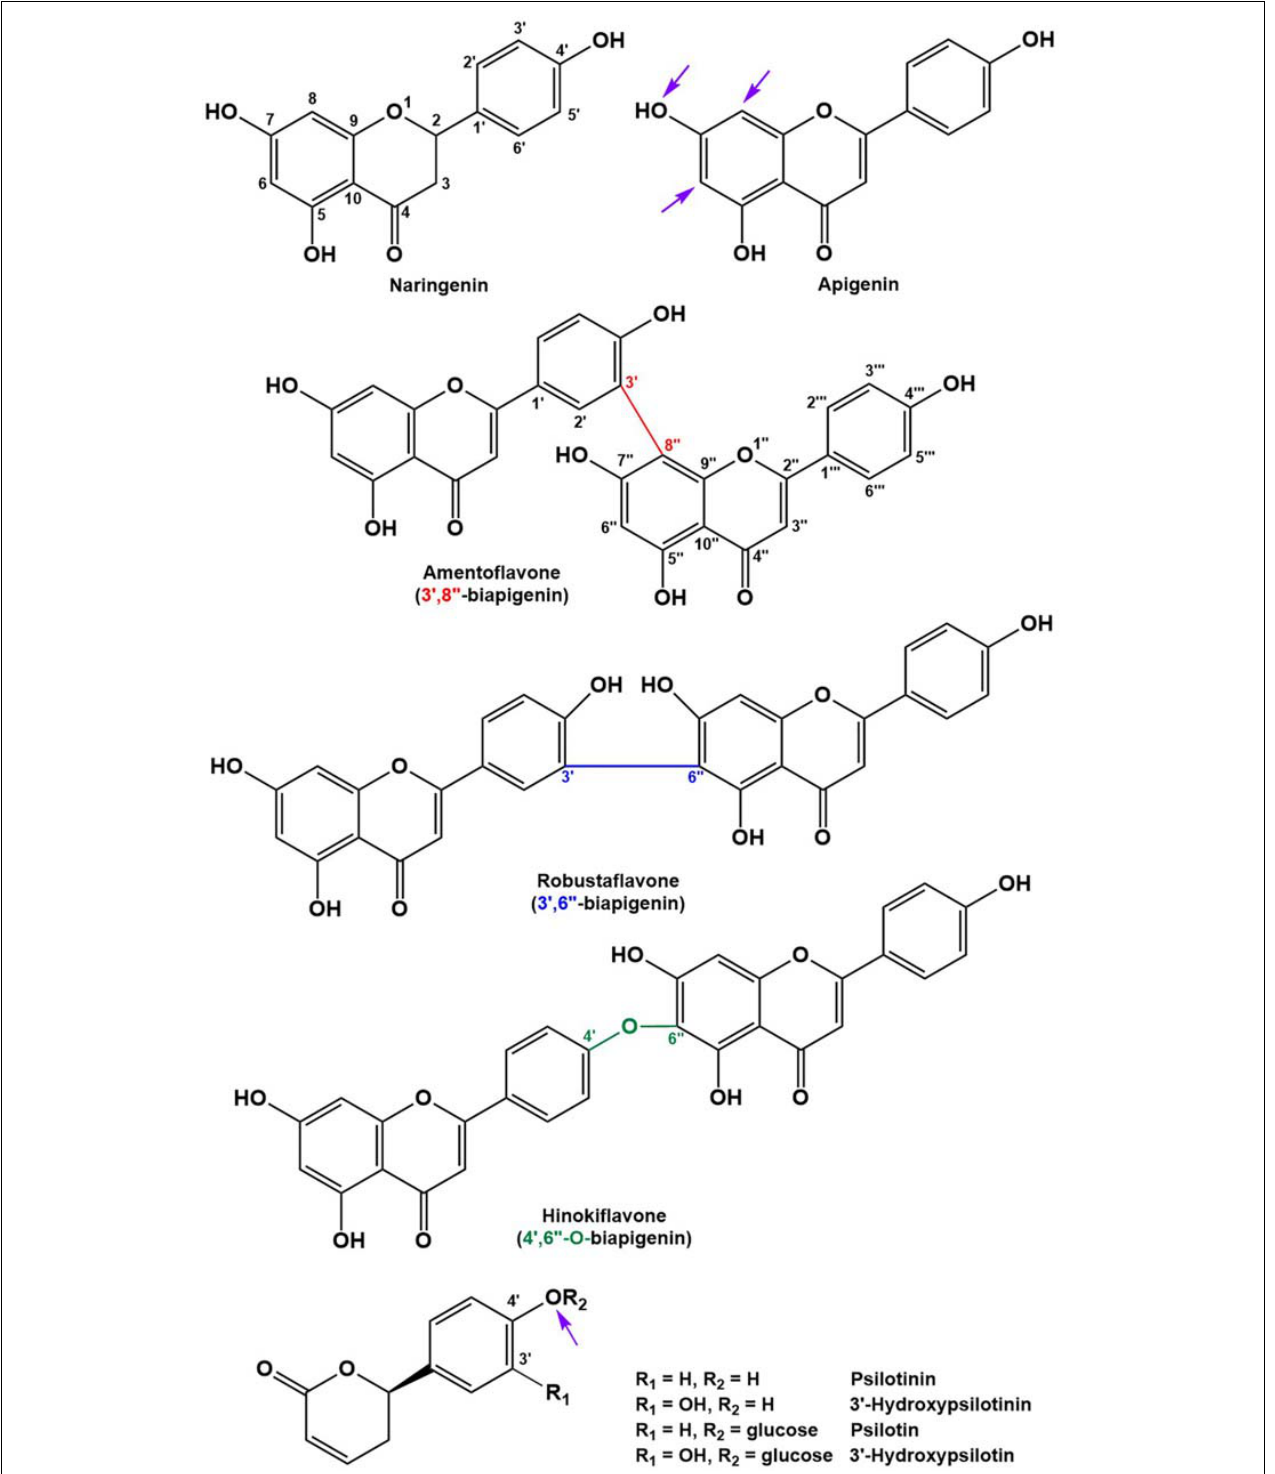
FIGURE 2 | Structures of the main flavonoid, biflavonoid and arylpyrone agylcones of P. nudum (positions for common glycosylation sites are indicated with purple arrows).